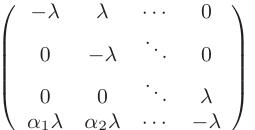
Figure 3: General unicyclic